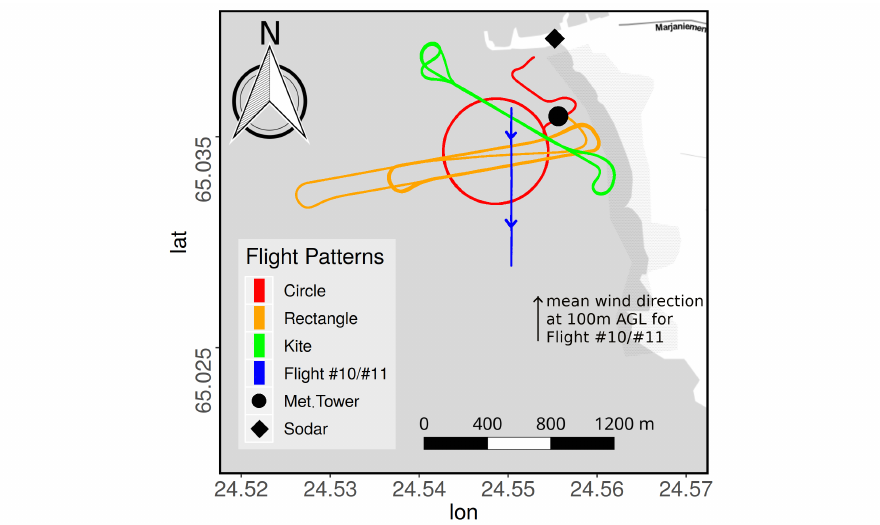
Figure 3. MASC-3 flight paths during the Hailuoto-II campaign. The island is indicated in white color and the grey area indicates water, which was completely frozen during the measurements allowing the installation of the indicated measurement tower. The sodar was installed on the island. The flight paths are plotted from the longitude and latitude readings of the inertial navigation system. The flight path section (leg) of Flight #10 and Flight #11 was used for the comparison between the tower, the Sodar and MASC-3. During Flight #10 and Flight #11 the mean wind direction at 100 m above ground level (AGL) is indicated. Map tiles by Stamen Design (http://stamen.com/) under CC BY 3.0